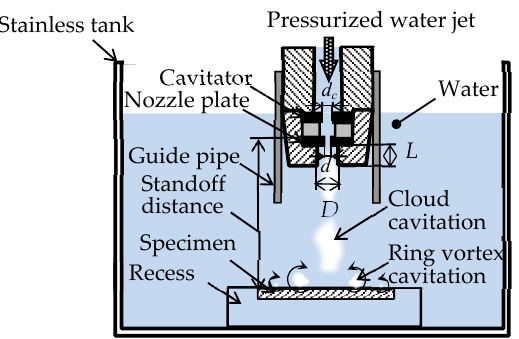
Figure 2. Schematic diagram of the peening section of the cavitation peening system.